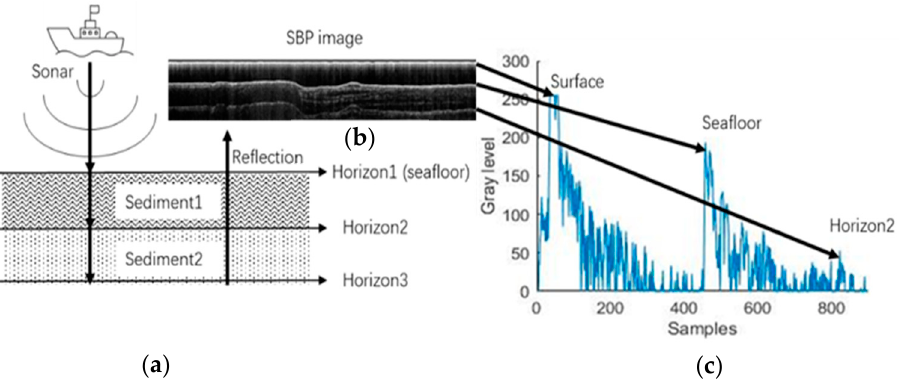
Figure 2. SBP survey. ( a ) The sonar of an SBP system converts the control signals to acoustic pulses (100 Hz–20 kHz) and emits the pulses towards the seafloor. After the pulse hits the sediment, acoustic energy reflected from the horizons is received by the transducer and is recorded as a time series called “ping”. ( b ) The ping is converted to a series of gray values, and all the adjacent pings compose an SBP image. ( c ) One ping reflection sequence. The three peak values of gray level correspond to the horizons in ( b ).